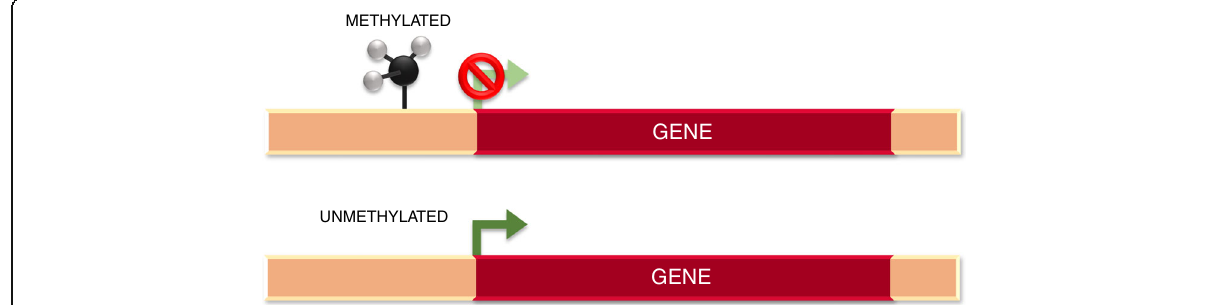
Fig. 4 Methylation can modify the expression of genes. Methylated regions upstream the start site of transcription are a signal of gene repression. Conversely, the absence of methylation promotes the transcription of the